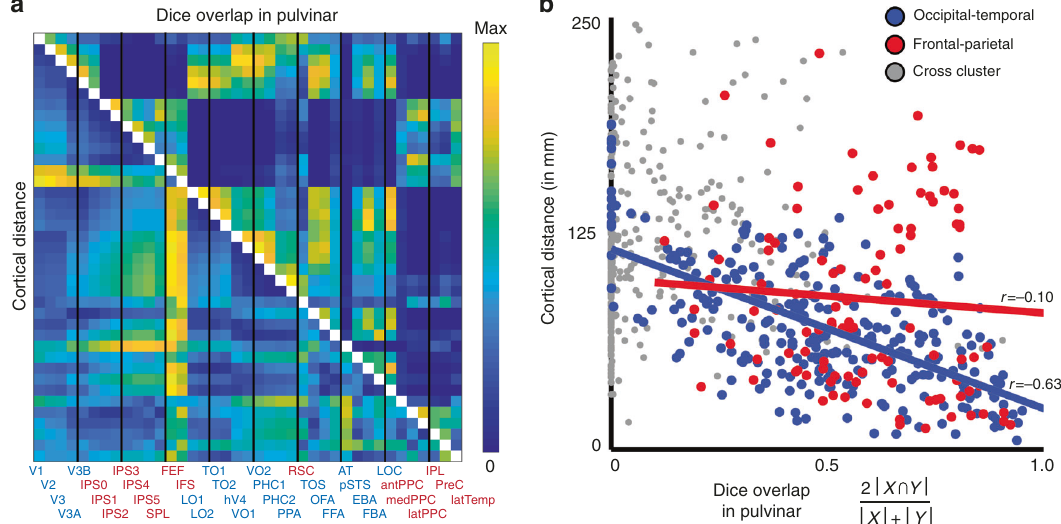
Fig. 4 Relationship between cortical distance and pulvino-cortical coupling. (left) Half matrices showing pairwise cortical distances and overlap in pulvino- cortical functional connectivity for all 39 cortical areas. Area labels are colored based on clustering in Fig. 2. Thin vertical black lines separate each block of four areas. (right) Scatter plot of cortical distance vs. overlap of pulvino-cortical connectivity for area pairs that were both part of the ventral pulvinar cluster (blue), dorsal pulvinar cluster (red), or for area pairs between clusters (grey). The correlation between cortical distance and pulvino- cortical connectivity overlap was signi fi cant for areas within the occipital-temporal cluster ( r = − 0.63, p < 0.0001), but not within the frontal-parietal ( r = − 0.10, p > 0.10). For all area pairs, Dice ’ s coef fi cient, 2 | A ∩ B | / (| A | + | B |), was